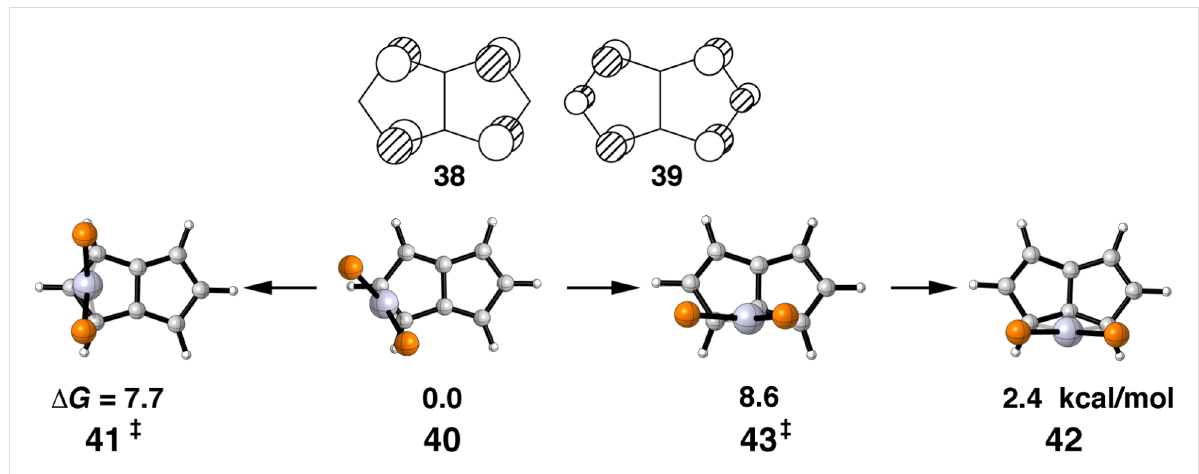
Figure 12: The LUMO and LUMO+1 shown in 38 and 39 , respectively. The four stationary points found for pentalene–Pt(dpe) are displayed in 40 – 43 along with their relative energies. The groups connected to the phosphorus atoms are not shown.